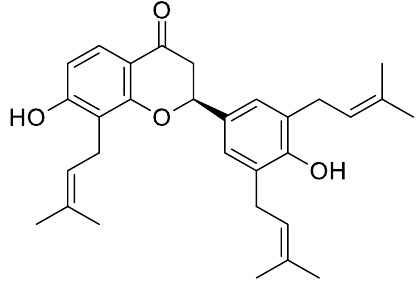
Figure 1. Chemical structure of ( ‒ )-sophoranone (SPN).